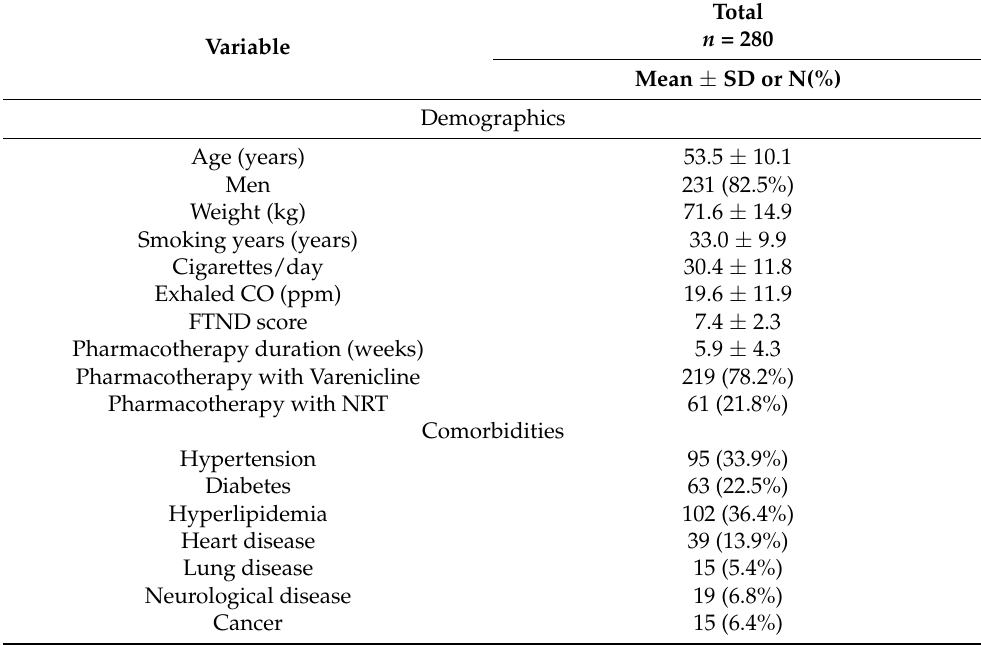
Table 1. Participants’ baseline